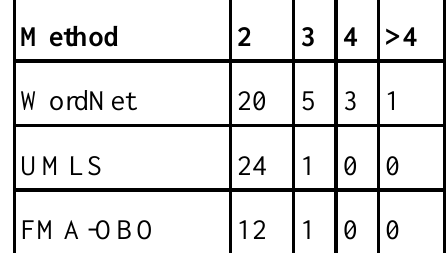
Table 3B: Ambiguity of predictions. Zebrafish terms mapped to 2 or more mouse terms.